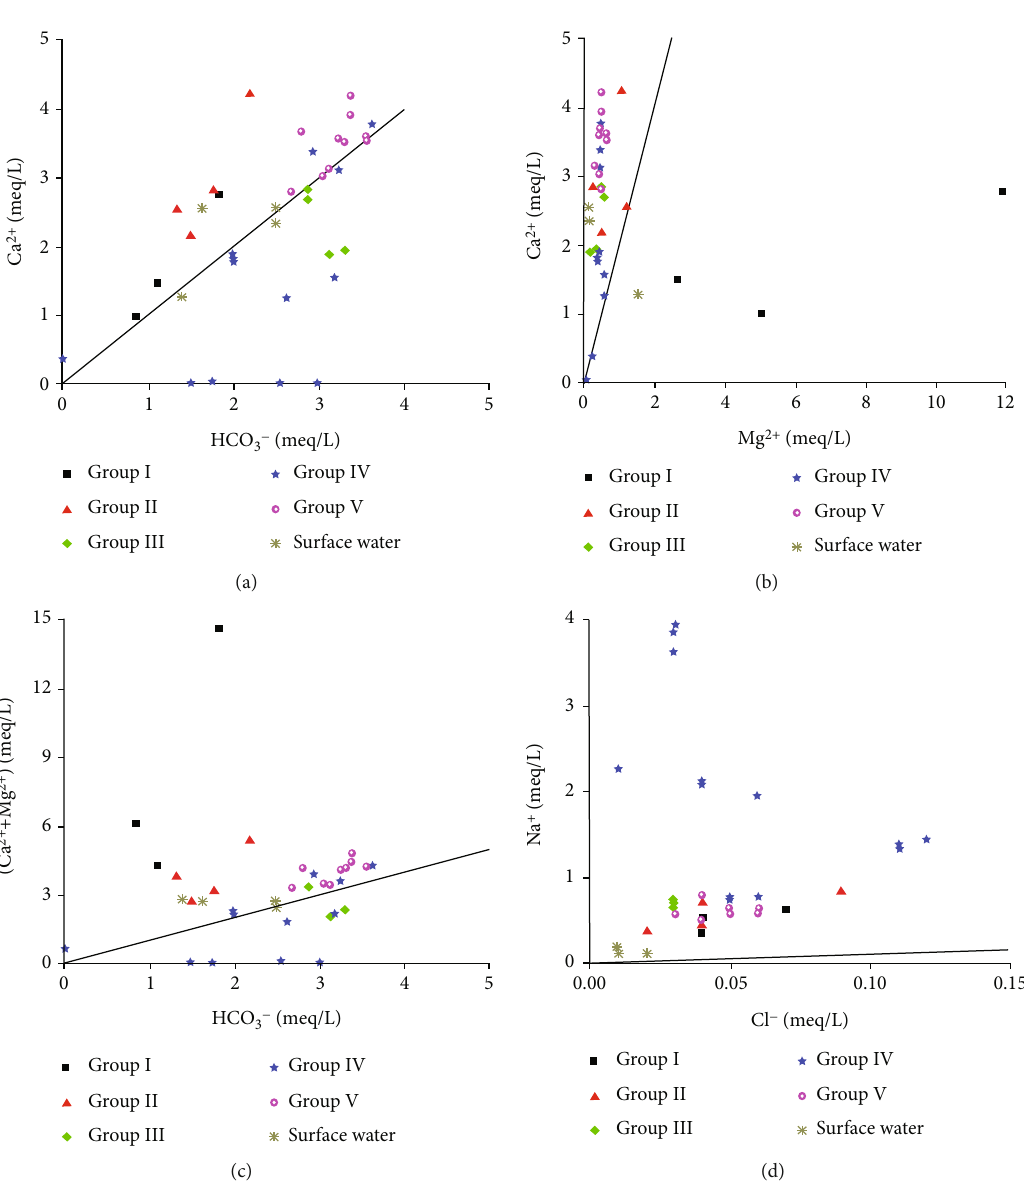
Figure 6: Ratio of main ions in the study